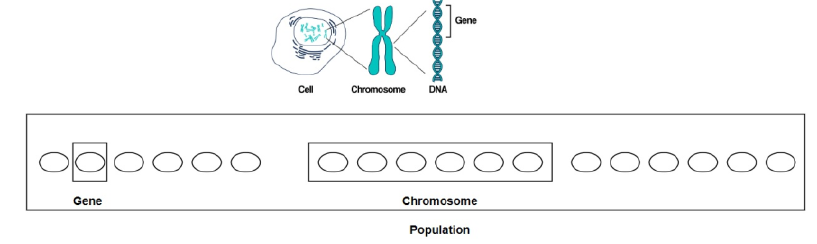
Fig. 1. Gene, Chromosome, and